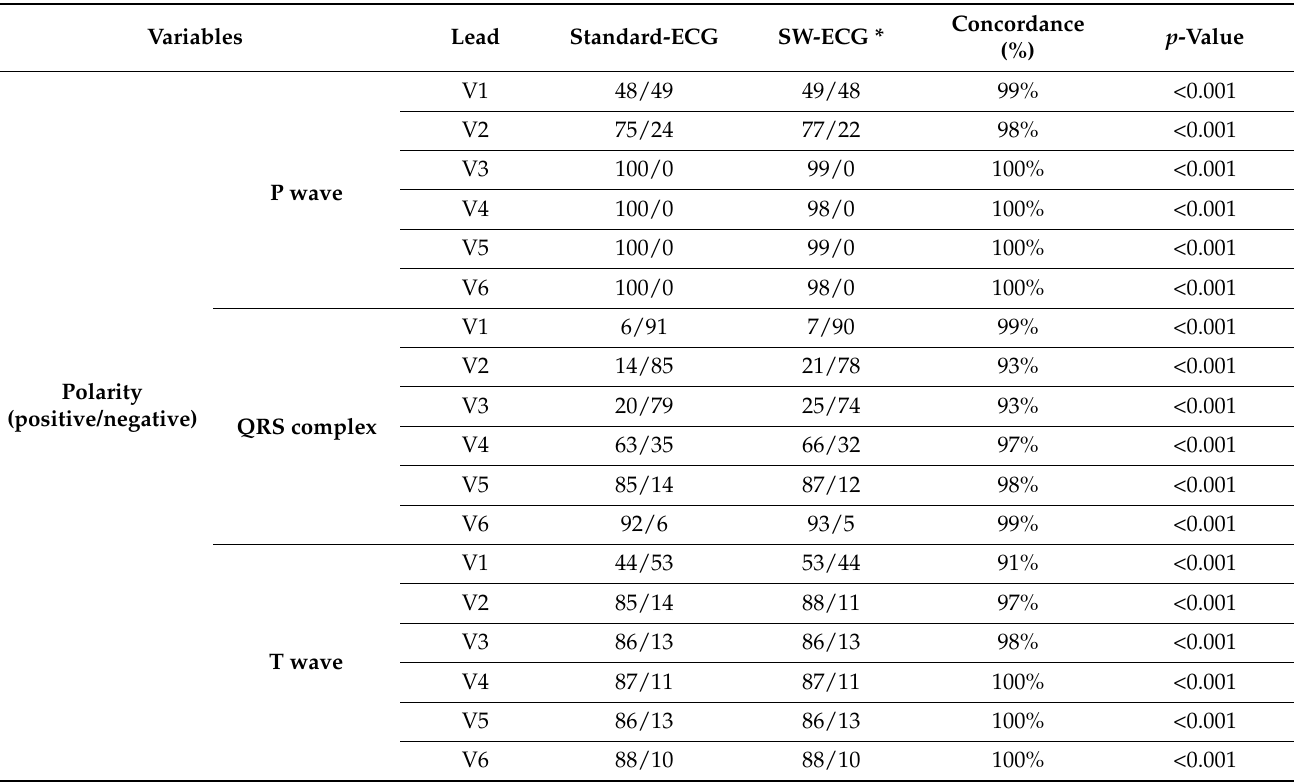
Table 4. ECG characteristics